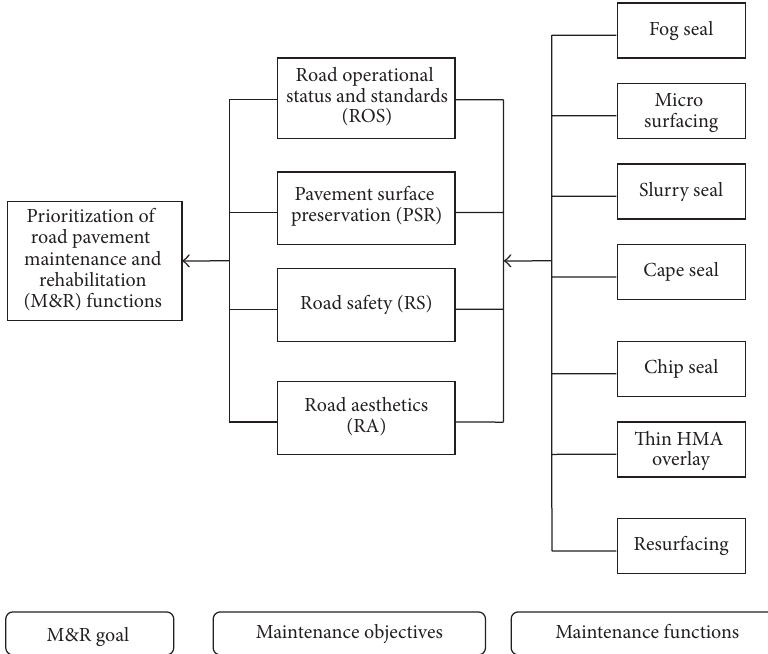
Figure 9: Three-level hierarchical structure of maintenance function prioritization process for the case study road.